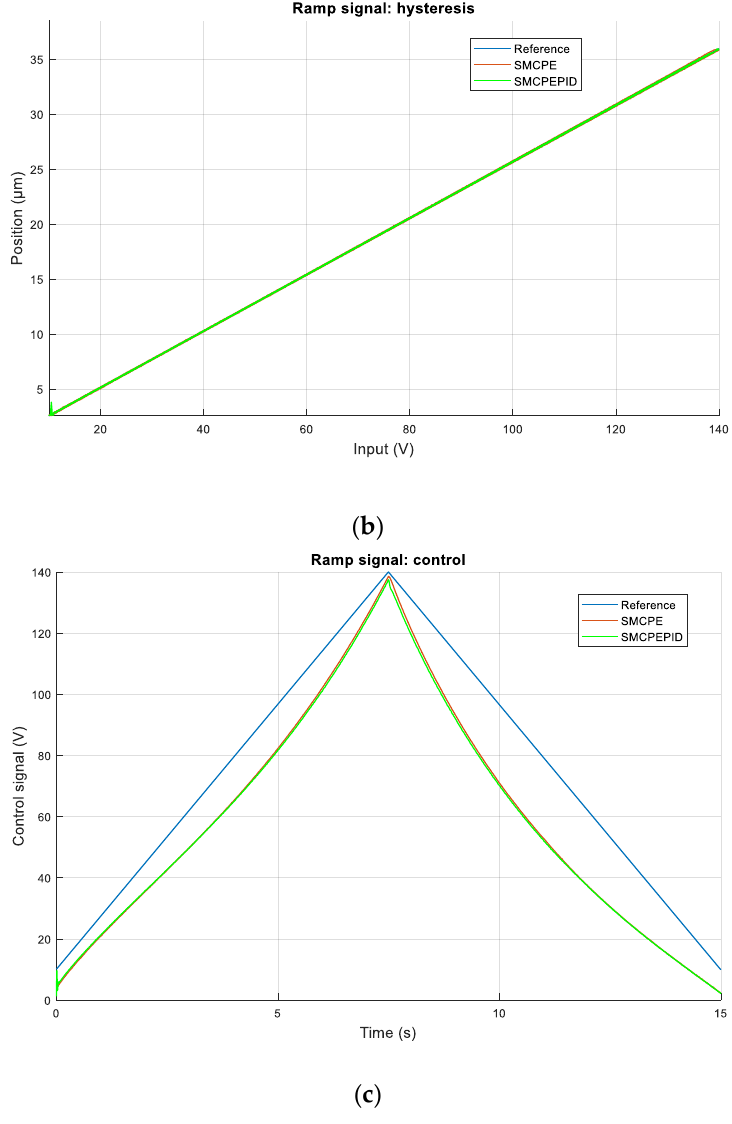
Figure 7. SMCPE vs. SMCPE–proportional–integral–derivative (PID) performance comparison for ramp signal tracking: ( a ) Error, ( b ) Position–reference, and ( c ) Control signal. Table 3. Integral of the absolute magnitude of the error (IAE) performance indicators for ramp